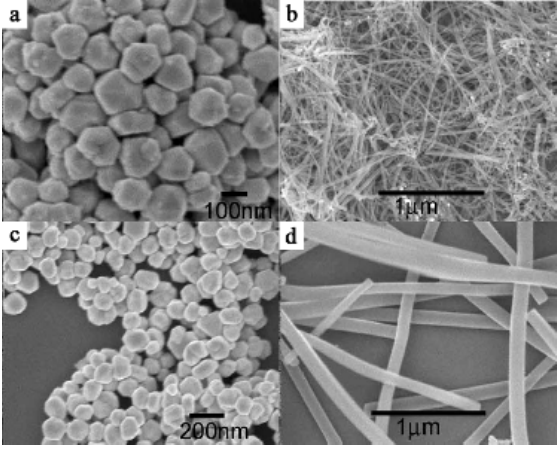
Figure 4. (a) Cu nanoparticles with diameters of about 60 − 130 nm. (b) Cu• TCNQ nanowires prepared by the two-phase method. (c) Ag nanoparticles with diameters of about 80 − 150 nm. (d) Ag• TCNQ nanowires prepared by the two-phase method. [Reproduced